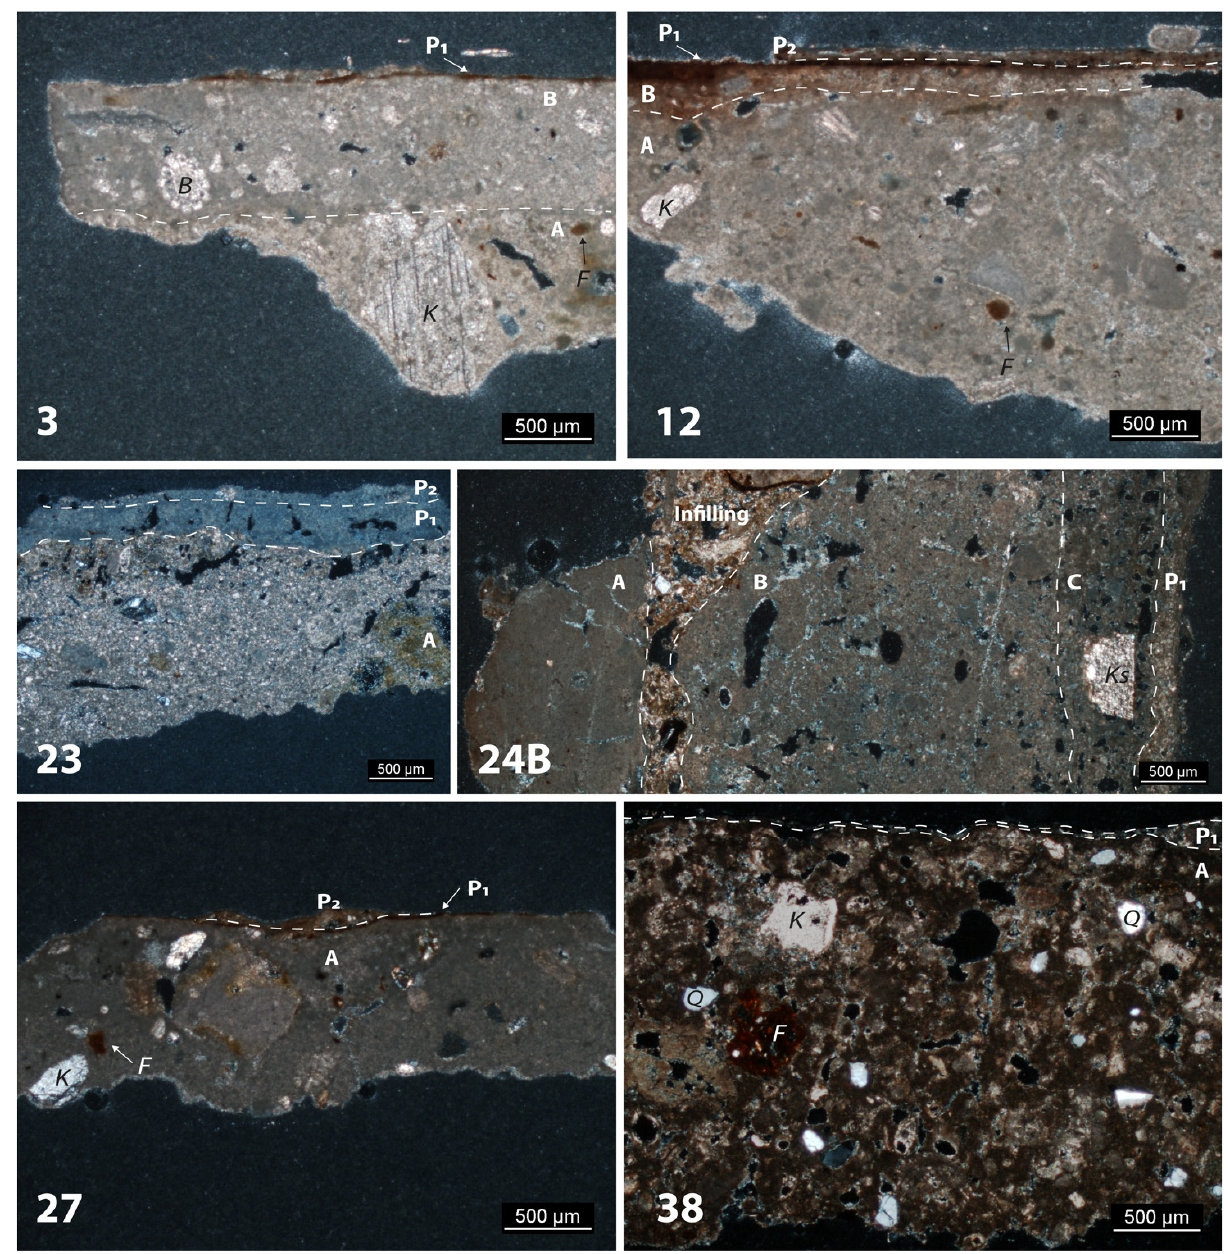
Figure 1. Photomicrographs (2.5X; XP) of samples (white bold numbers) of the different tombs. Plaster (A, etc) and painting (P 1 , etc) layers are indicated, with their relative stratigraphic boundaries (dasched lines).